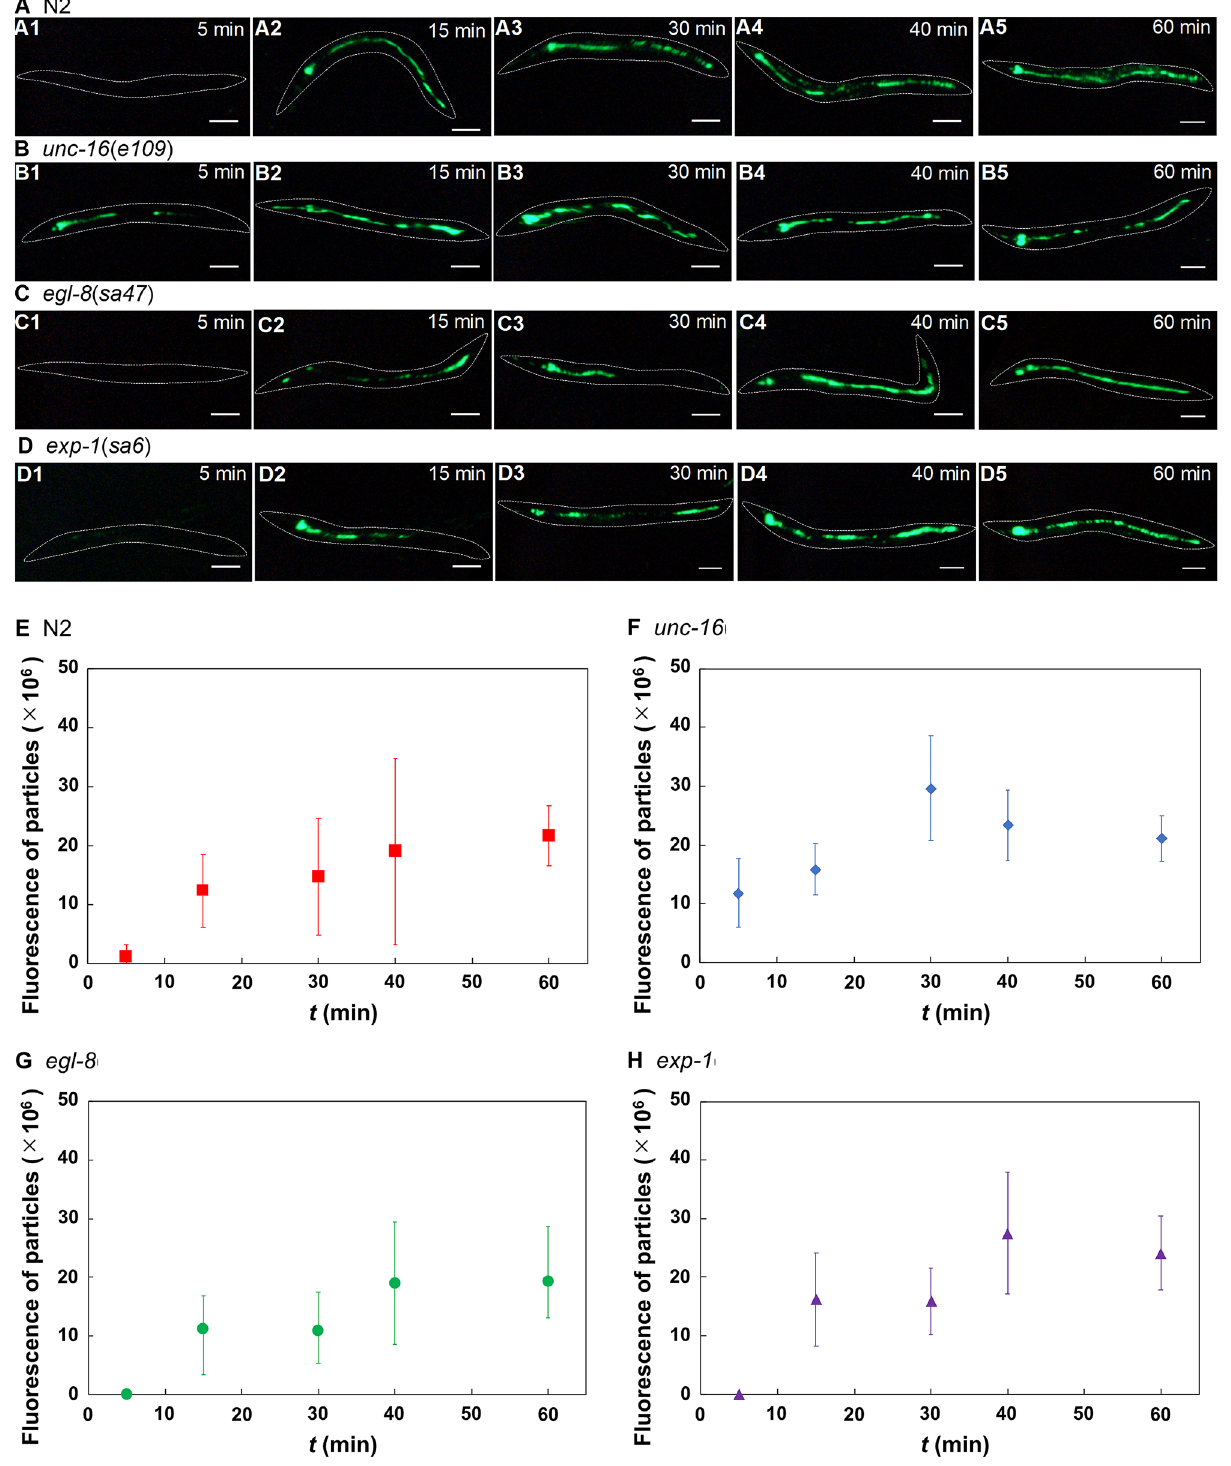
Figure 3. Distribution of fluorescent particles in the intestine at 5, 15, 30, 40, and 60 min. ( A-D ) Fluorescence images of particles in the intestine. White dotted lines are worm outlines. Time required for ingestion of particles is shown at upper right. Scale bars, 100 µm. ( A ) N2. (B ) unc-16 ( e109 ). ( C ) egl-8 ( sa47 ). ( D ) exp- 1 (sa6). ( E–H ) Change in the total fluorescence of ingested particles in the intestine over time. Data are means ± standard deviations. ( E ) N2; n ≥ 12 worms. ( F ) unc-16 ; n ≥ 11 worms. ( G ) exp-8 ; n ≥ 10 worms. ( H ) exp-1 ; n ≥ 10